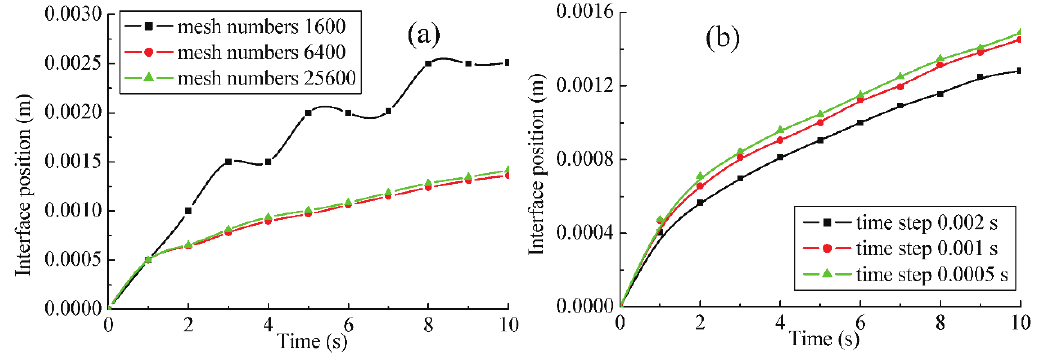
Figure 4. Sensitivity study on mesh number ( a ) and time step ( b ).